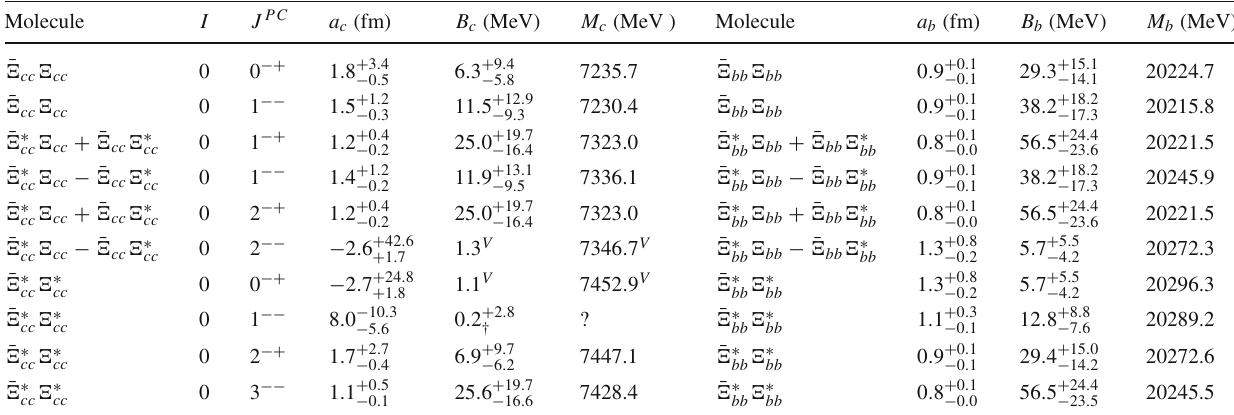
Table 5 Scattering lengths ( a in fm), binding energies ( B in MeV, if bound states exist) and mass spectra ( M in MeV) of prospective isoscalar heavy baryon-baryon molecules. The superscript V denotes the existence of virtual states, the † symbol denotes that the system is unbound, and the ? symbol indicates that the system is bound with the